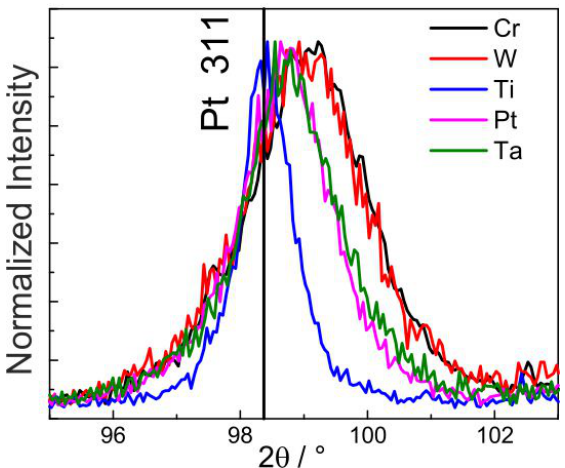
Figure 2. Comparison of the Pt peak width for the Pt ∗ films with the various seed layers in the as-deposited